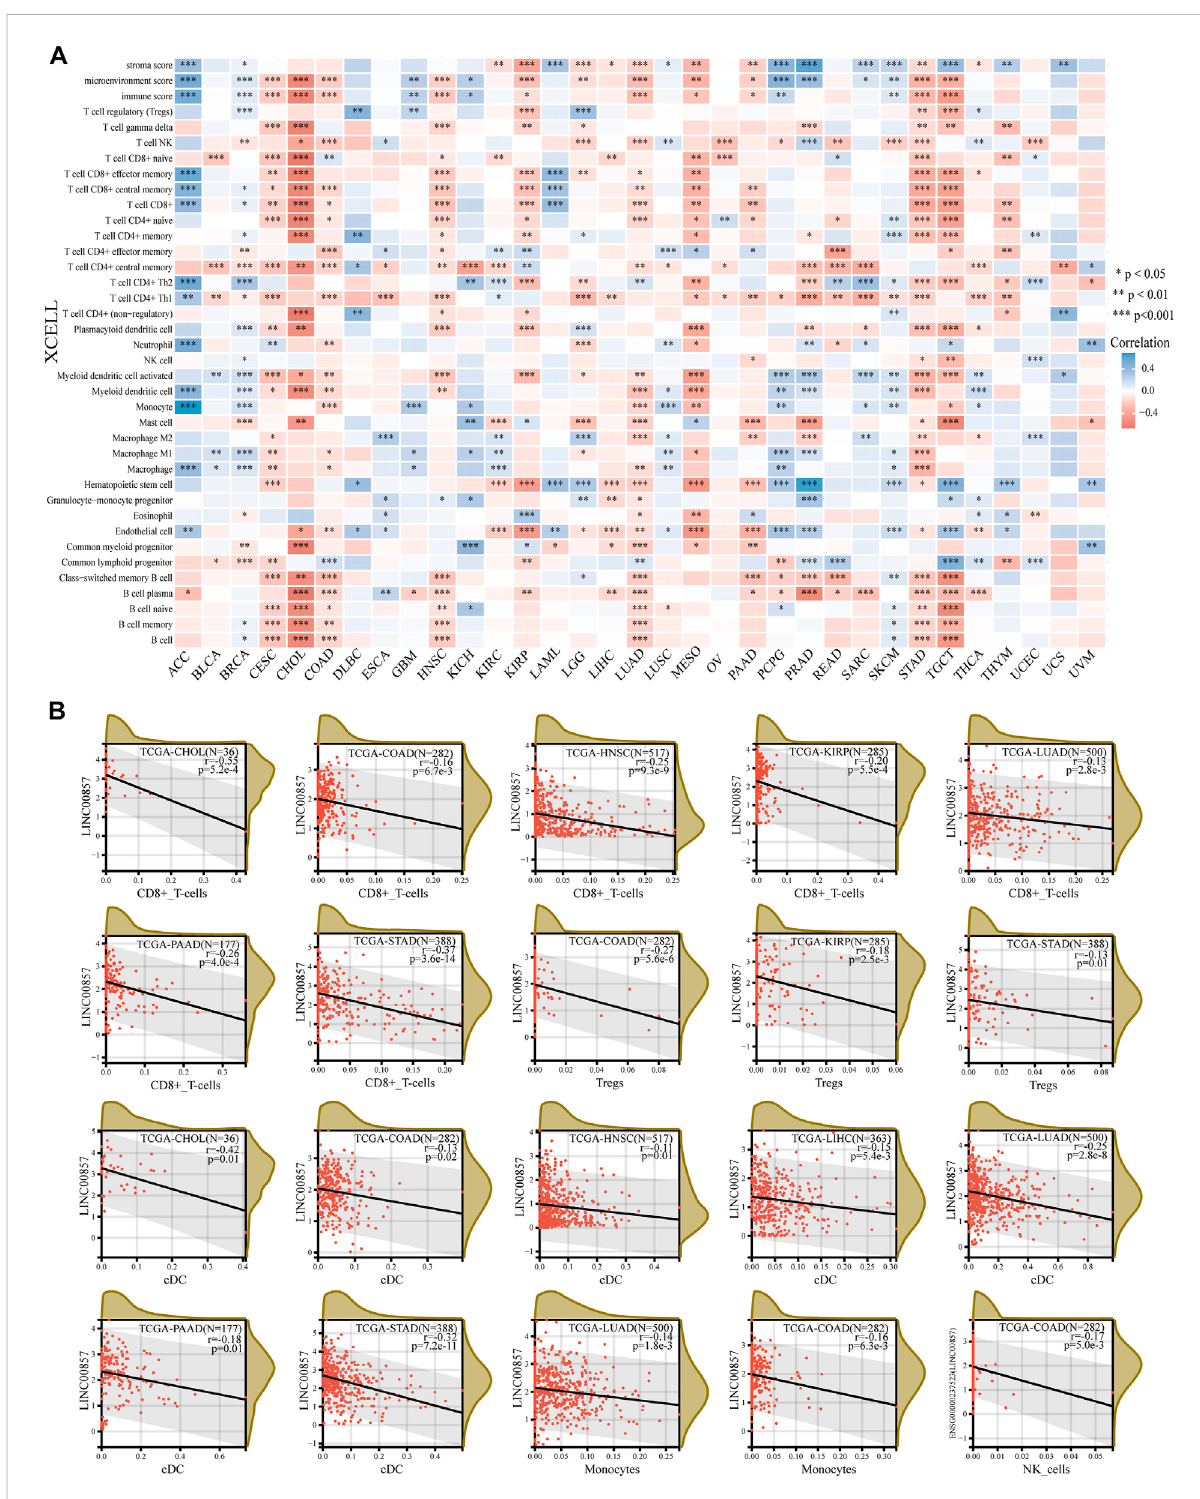
The correlation between LINC00857 expression and immune cell in fi ltration. (A) The interrelation heatmap between LINC00857 expression andimmunecellin fi ltrationlevelswasexaminedbytheACLBIdatabase(XCELLalgorithm).(* p < 0.05,** p < 0.01,*** p < 0.001,Spearmananalysis) (B) Scatter plots of the pertinence between LINC00857 expression and the in fi ltration levels of monocyte, NK cell, conventional DC, Treg and CD8+T cell by the Sangerbox 3.0 database (XCELL algorithm) (* p < 0.05, ** p < 0.01, *** p < 0.001, Pearson